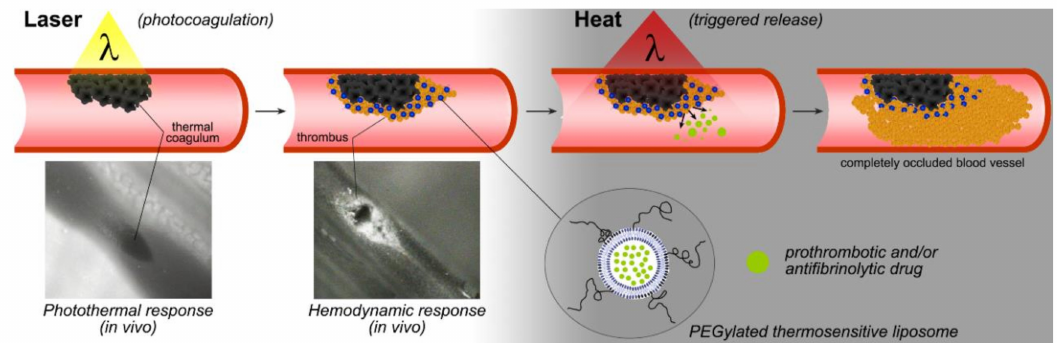
Figure 1. Theoretical principles of site-specific pharmaco-laser therapy (SSPLT) in the context of incompletely photocoagulated port wine stain (PWS) vessels, which are responsible for therapeutic recalcitrance. The processes are divided into conventional laser treatment by selective photothermolysis (white background) and the additional procedures of SSPLT (gray background). PWS vasculature is illuminated with a yellow laser pulse ( λ ), leading to the photocoagulation of blood and the formation of a thermal coagulum. Thermal coagula are inherently pro-thrombotic and therefore trigger coagulation and platelet aggregation at the thermal coagulum interface. In time, the thrombi dislodge or break down and the PWS vessels remain only partially occluded. In SSPLT, thrombus-targeting thermosensitive liposomes containing anti-fibrinolytic and / or prothrombotic agents are systemically administered directly before conventional laser treatment to ensure that the highest possible amount of liposomes is present in the circulation during lasing. Upon encountering a laser-induced thrombus, the liposomes accumulate in the developing clot. Next, a second laser emitting red light ( λ ) is used to induce mild hyperthermia in PWS skin, causing the phospholipid bilayer to undergo phase transition and release the encapsulated drugs that locally exacerbate the degree of thrombosis to the extent of entirely occluding the vascular lumen (clinical